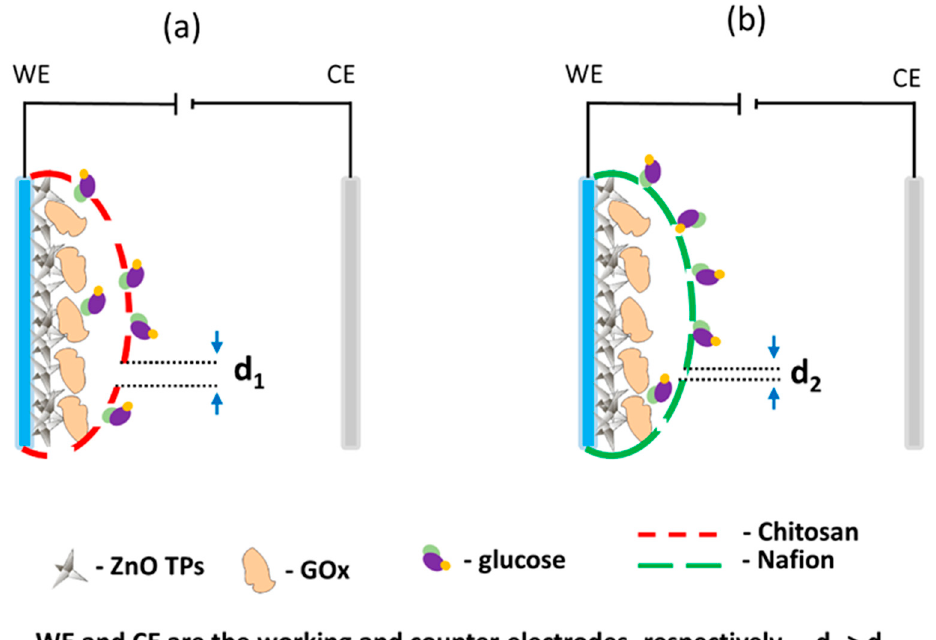
Figure 6. Schemes of the ZnO TPs/chitosan ( a ) and ZnO TPs/Nafion electrodes ( b ). Interpretation of the effect of micelle size on glucose transport through a semi-permeable polymer